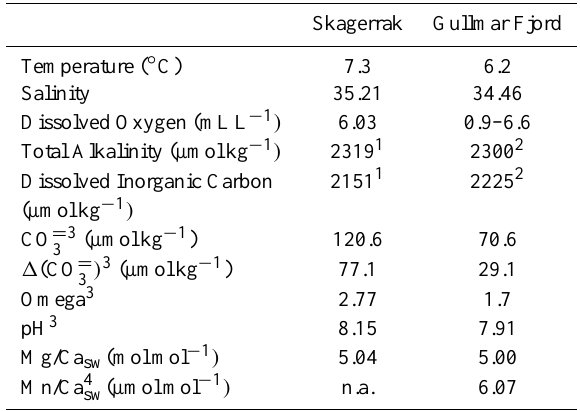
Table 1. Water mass conditions, including temperature, salinity, car- bonate system parameters, Mg/Ca sw , and Mn/Ca sw for the Skager- rak (site FÅ17) and the Gullmar Fjord (site